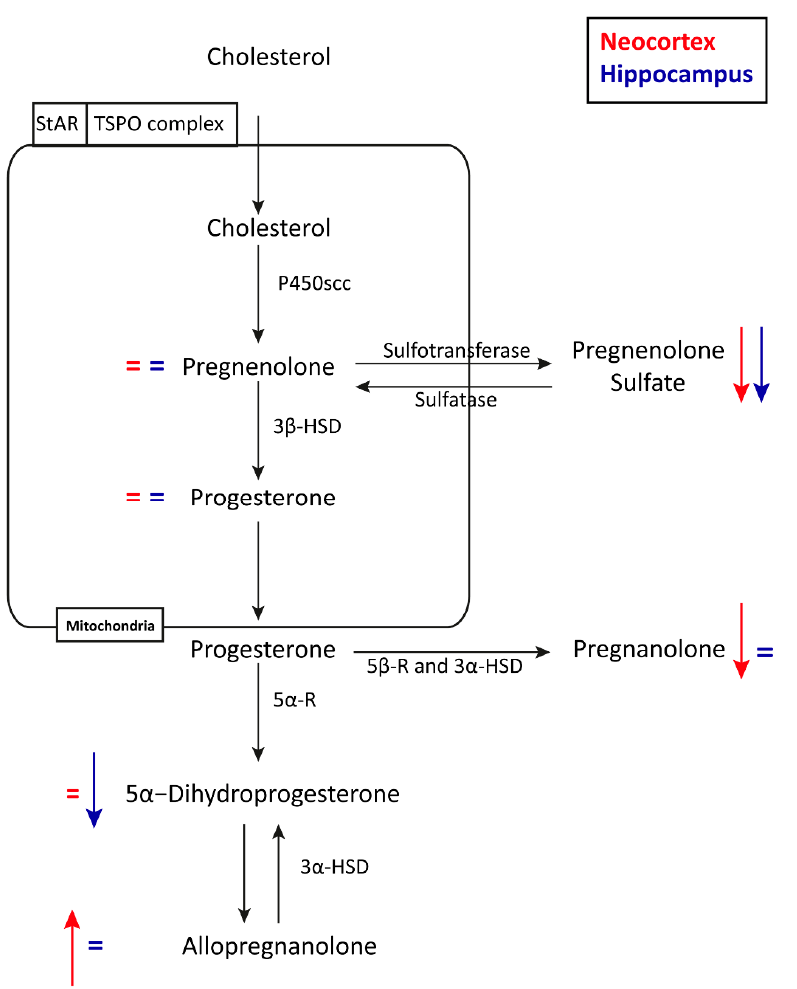
Figure 5. Diagram of neurosteroid synthesis and levels of neurosteroids in epileptic rats treated with levetiracetam (LEV) or saline. Changes in neurosteroids’ neocortical levels of LEV-treated rats are illustrated by red arrows, whereas changes in neurosteroids’ hippocampal levels of LEV-treated rats are illustrated by blue arrows. StAR, steroidogenic acute regulatory protein; TSPO, translocator protein; P450scc, cytochrome P450-associated cholesterol side chain cleavage enzyme; 3 α -HSD, 3 α -hydroxysteroid dehydrogenase; 3 β -HSD, 3 β -hydroxysteroid dehydrogenase/ Δ 5-4 isomerase; 5 α -R, 5 α -reductase; 5 β -R, 5 β -reductase.